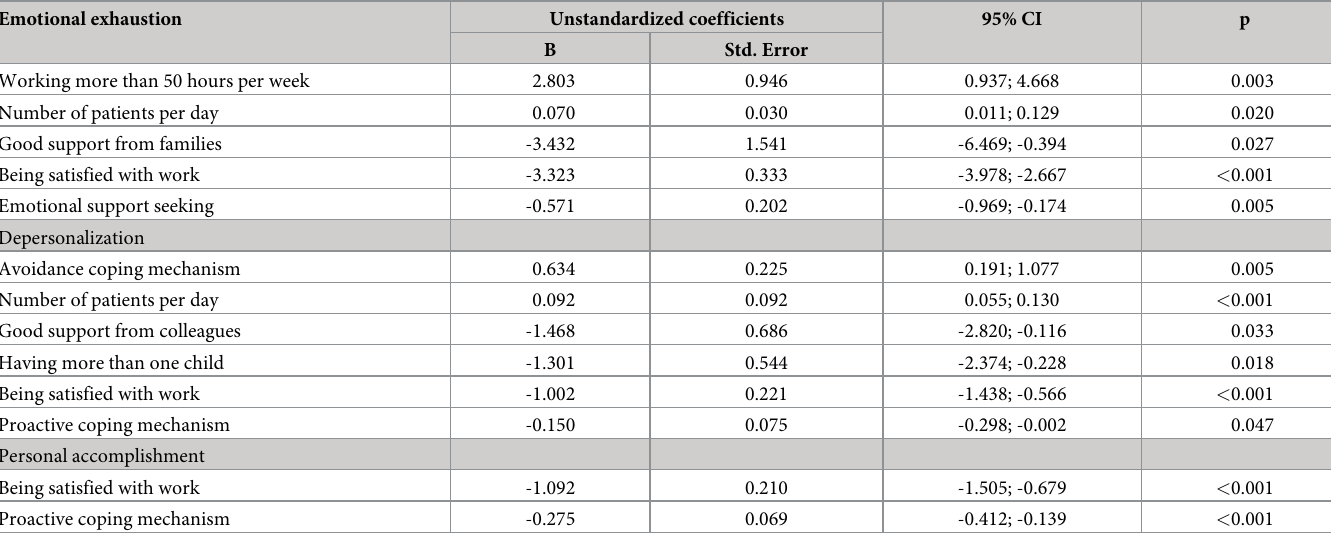
Table 3. Factors associated with burnout: Multiple linear regression